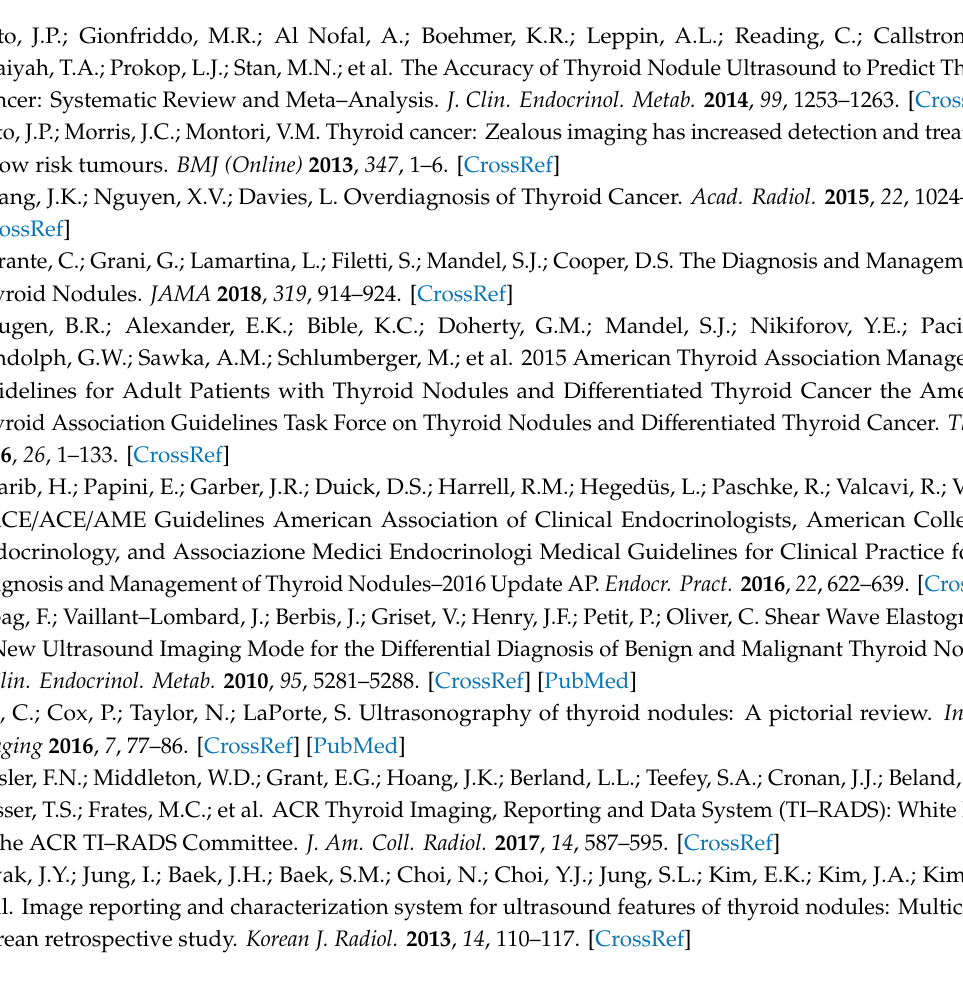
Figure S1: QUADAS Risk of bias summary, Figure S2: QUADAS Applicability Concerns. Table S1: PRISMA 2009